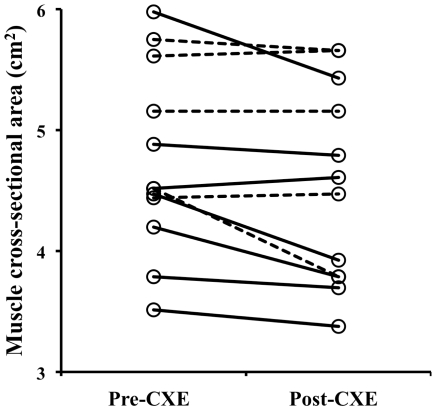
Individual changes in muscle cross-sectional area after a trip to high-altitude.Dashed lines are climbers, solid lines are altitude-naïve subjects. Change in mean values is significant at p<0.05, n = 12.